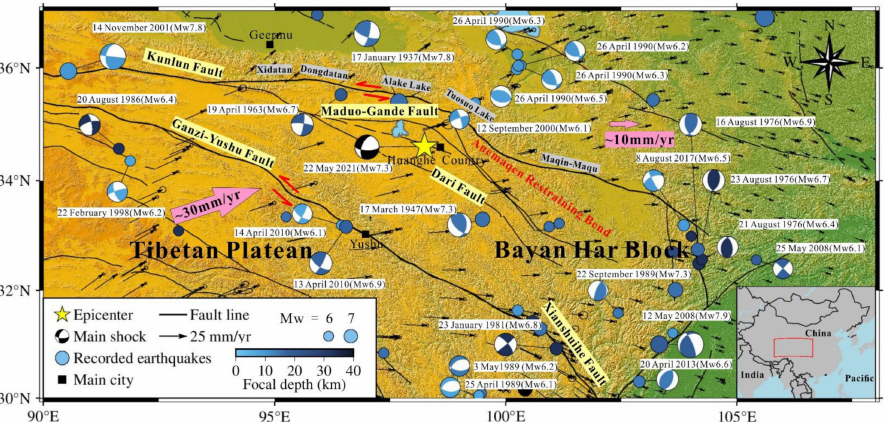
Figure 1. Tectonic background of the 2021 Mw 7.3 Maduo earthquake. The black solid lines indicate the fault surface trace, and the bold black lines denotes the boundary fault of the Bayan Har block. The red rectangle indicates the area of interest. Black arrows show the GPS horizontal velocity, white arrows with numbers are block motion rate, blue balls and beach balls indicate the locations and source mechanism of historical earthquakes, yellow star denotes the epicenter of the 2021 Maduo earthquake, and the black beach ball indicates the source mechanism solution of the main